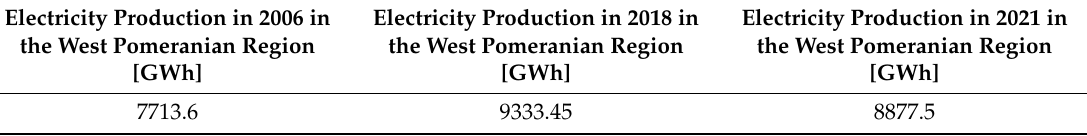
Table 7. Electricity production forecast in the West Pomeranian Region in 2021 according scenario I. Electricity Production in 2021 in Electricity Production in 2018 in Electricity Production in 2006 in the West Pomeranian Region the West Pomeranian Region the West Pomeranian Region [GWh] [GWh] [GWh] 7713.6 9333.45 8877.5 Source: Ref. [47].